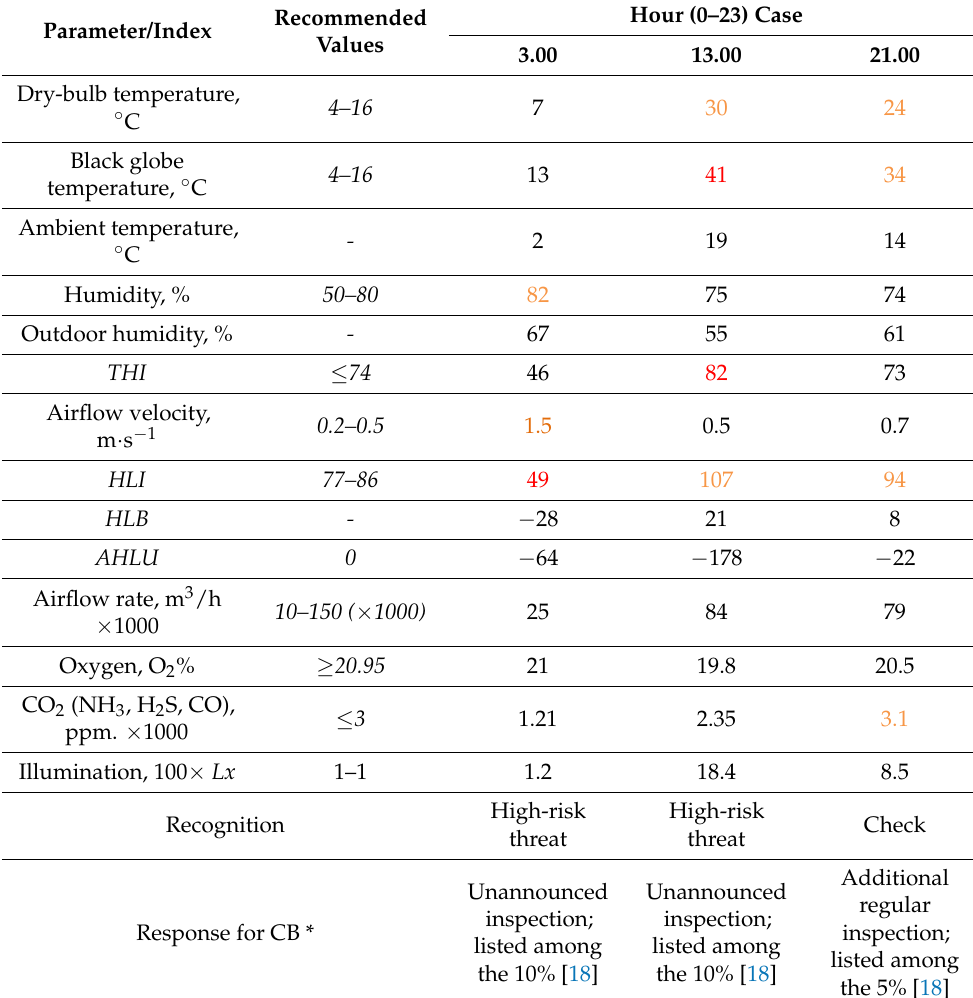
Table 11. Causal relationships in the three considered